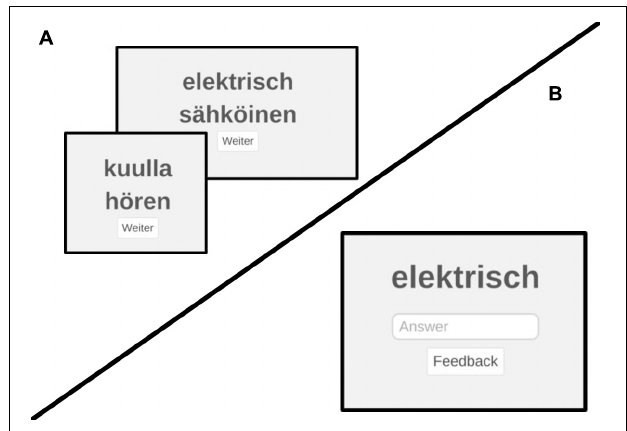
FIGURE 1 | Screenshots of learning and retrieval trials in the web app. Screenshots showing examples of learning trials (A) and retrieval trials (B) as they were displayed to participants in the web applications. Translation for German terms: “Weiter” = “continue.”